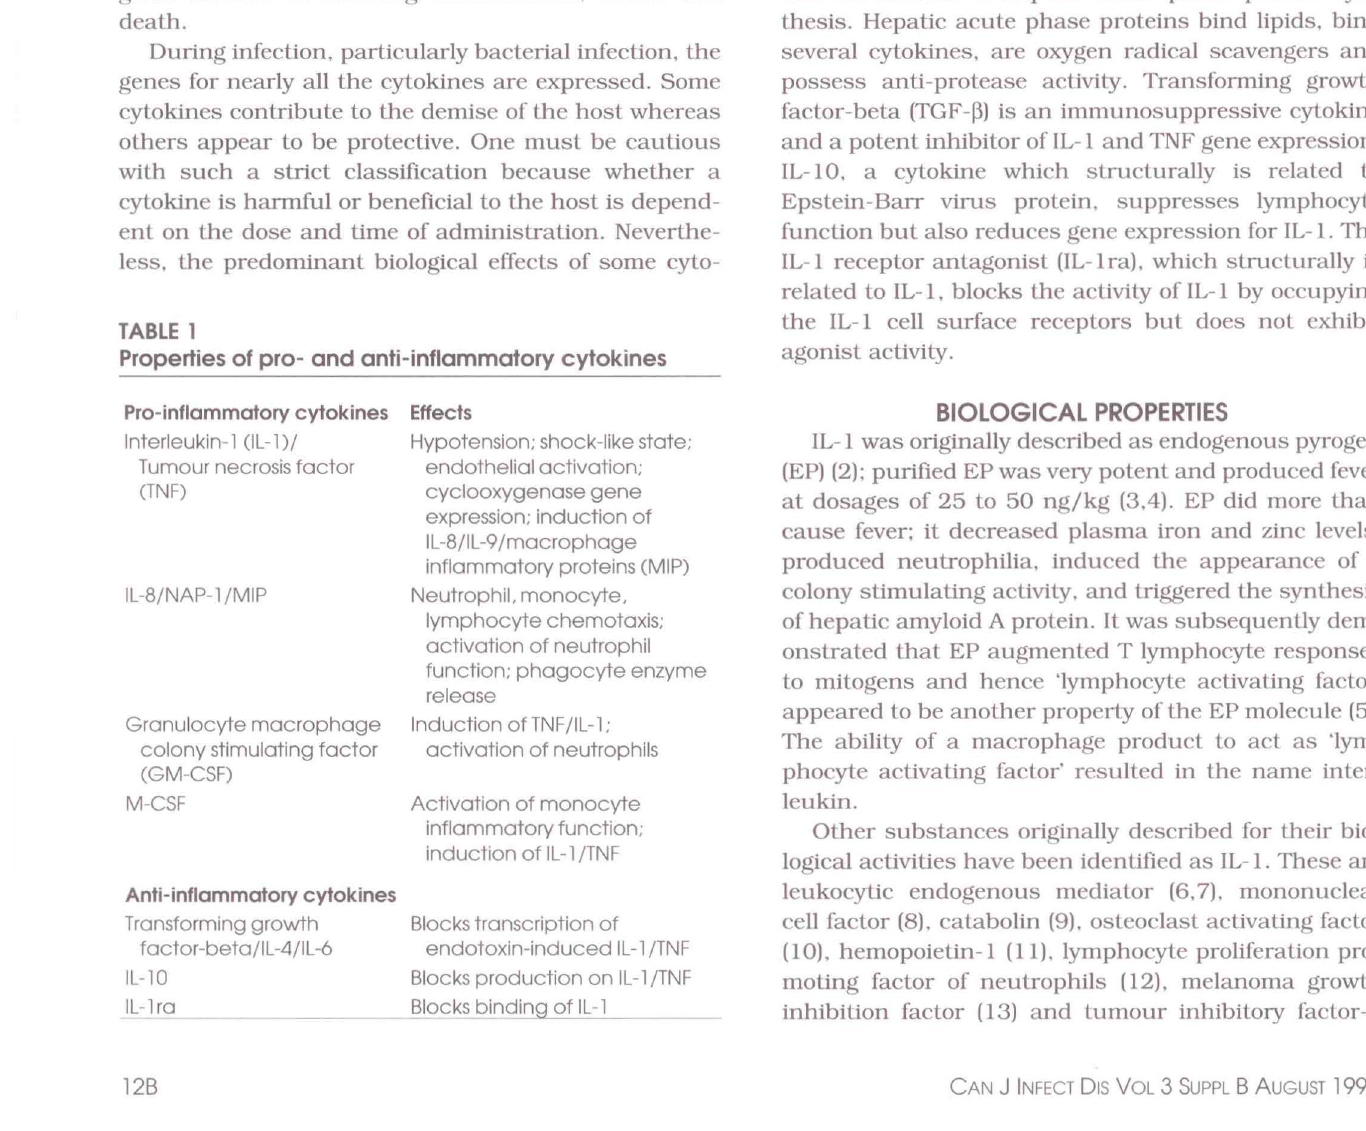
Properties of pro- and anti-inflammatory cytokines Pro-inflammatory cytokines